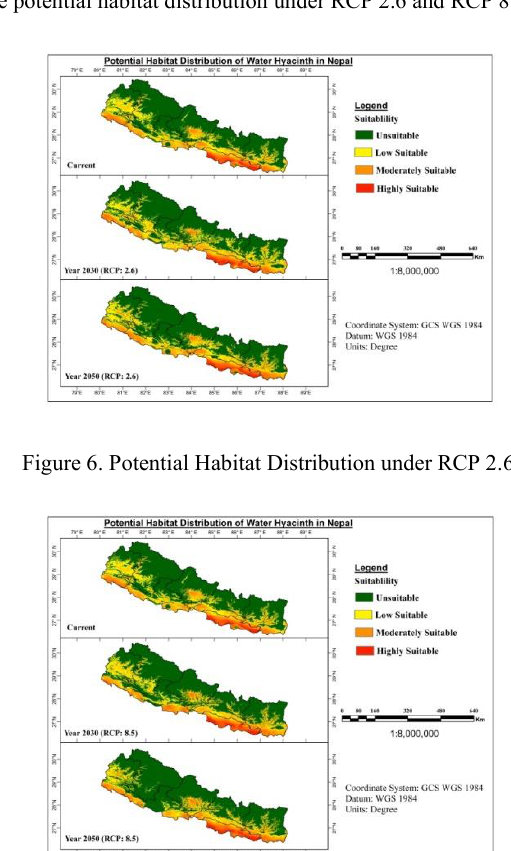
Figure 10. Potential Habitat Distribution of Water Hyacinth in the lakes of Nepal in year 2050 under RCP 2.6